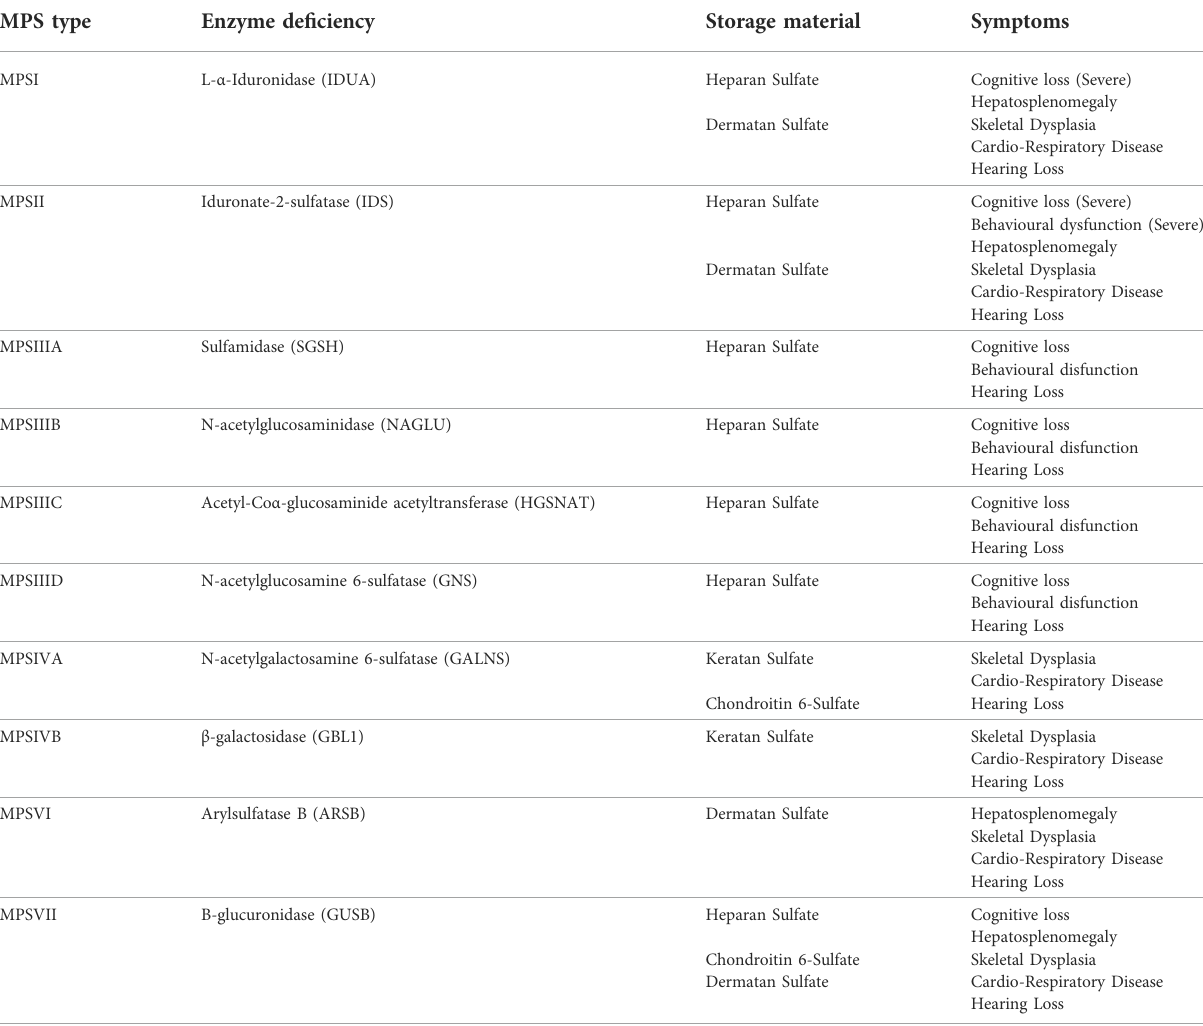
TABLE 1 MucopolysaccharideDiseases, Enzymes, Storage Material and Symptoms. * MPSIX(hyaluronan de fi ciency) — somaticbone and joint disease, only one case